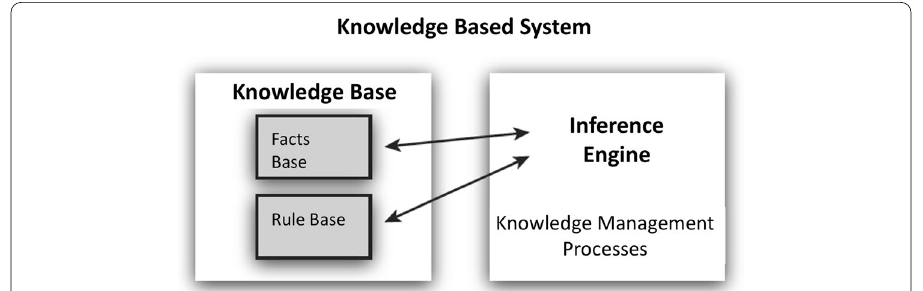
Fig. 4 Particular type of knowledge-based system: rule-based ( adapted from Savard (2014), p. 76, with the author’s